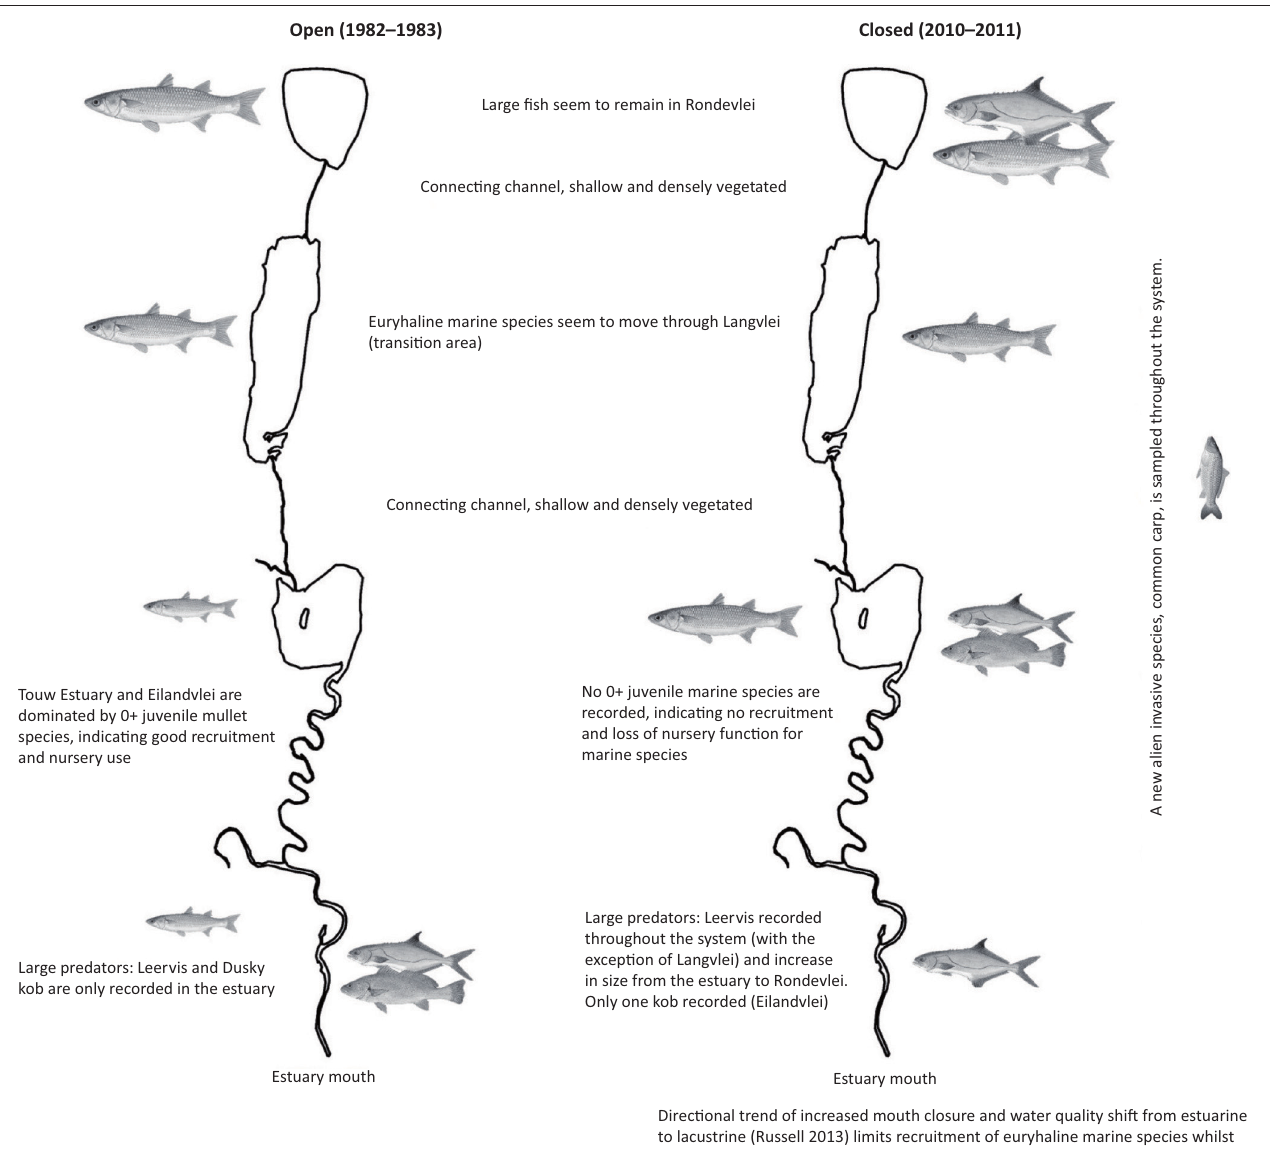
FIGURE 6: Comparison of the fish communities between a predominantly open phase (1982–1983) and a predominantly closed phase